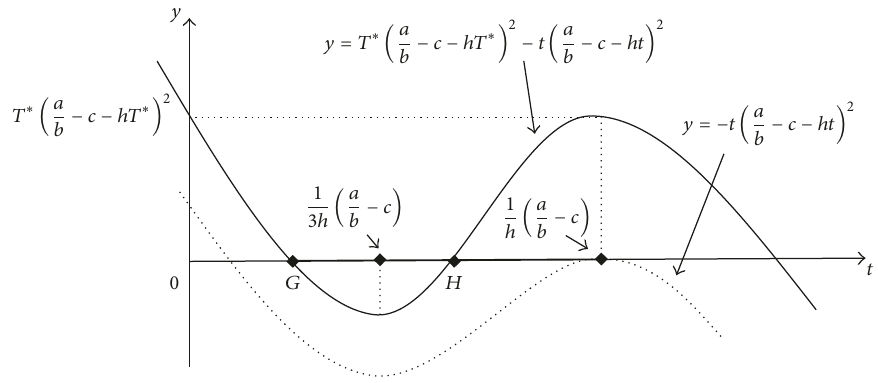
Figure 2: Effect of the increase in 𝑒 on 𝑇 ∗